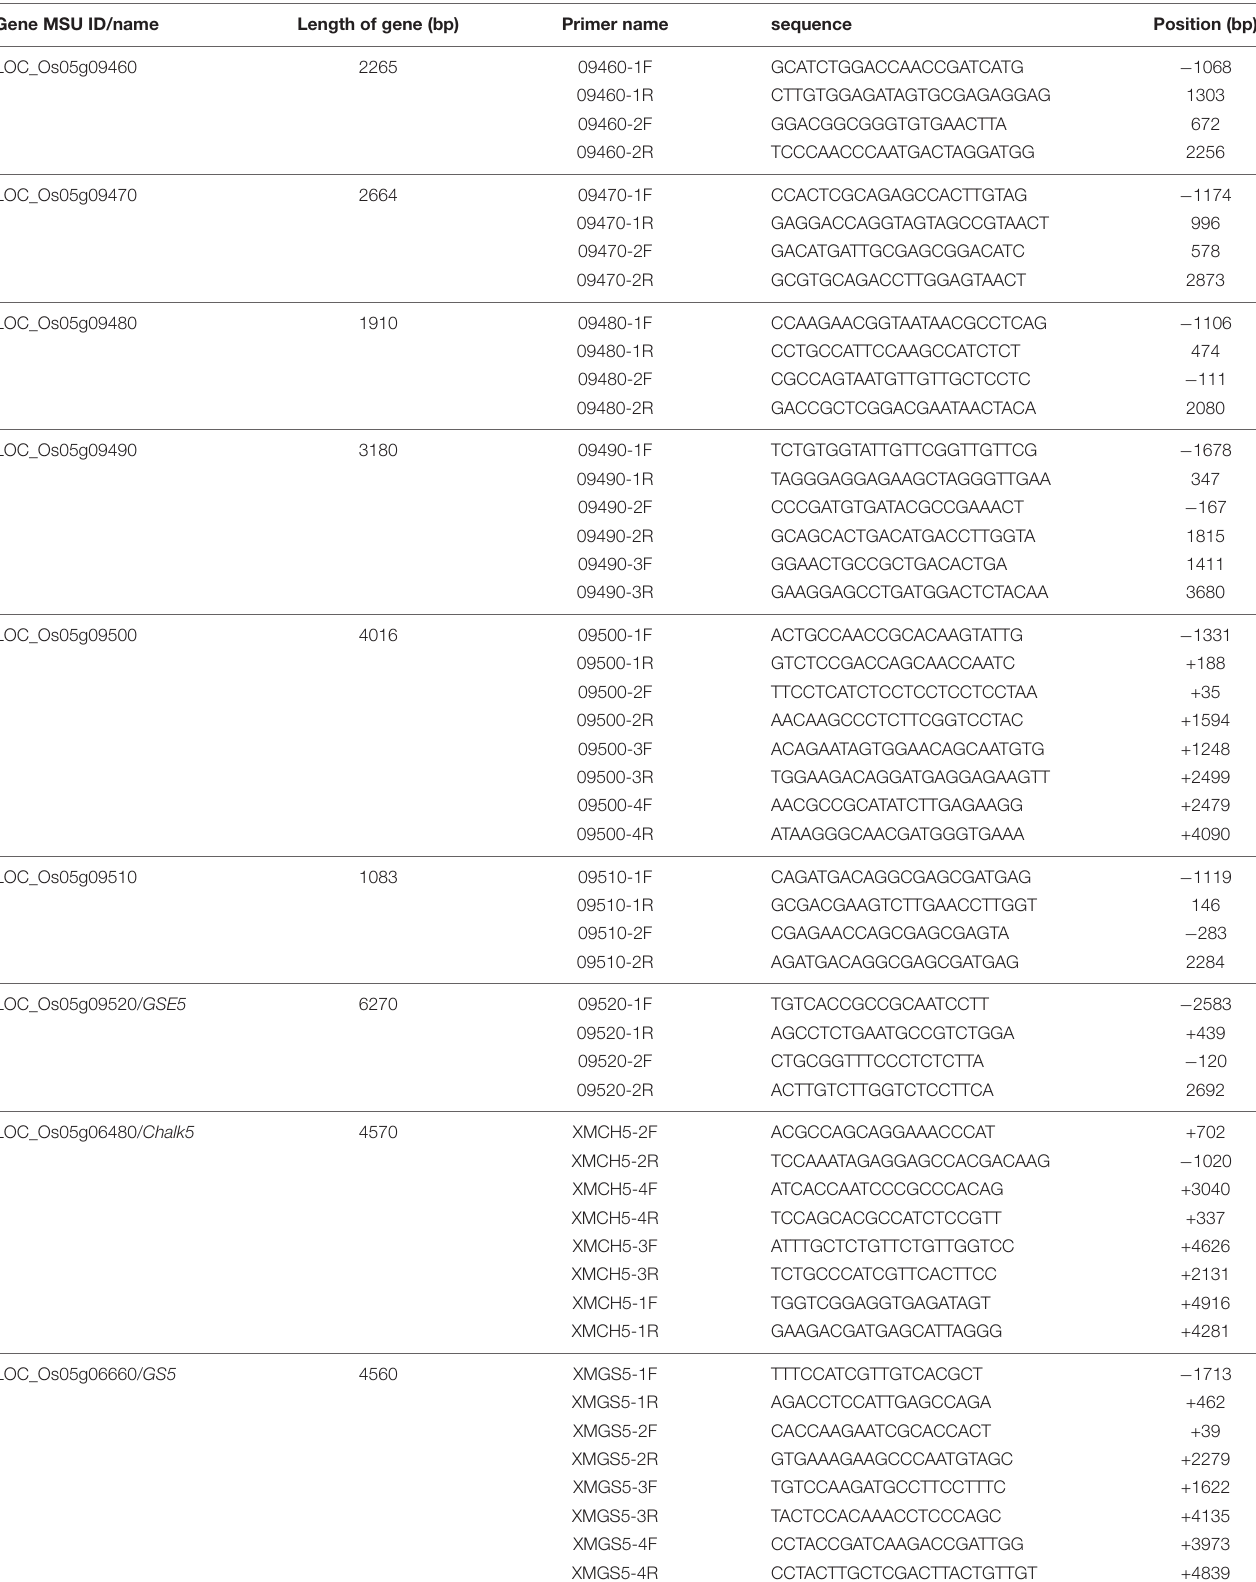
TABLE 2 | Primers for amplifying the full-length sequences of the genes in the target interval, Chalk5, and GS5